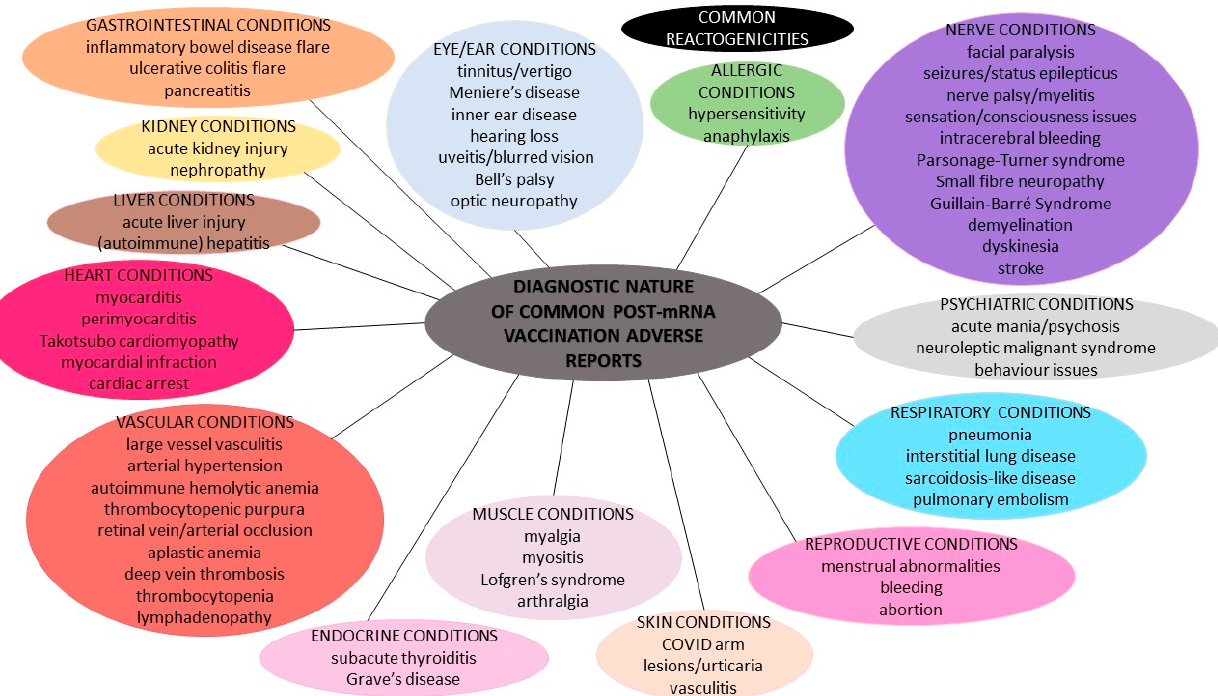
Figure 1. Diagnostic nature of the spontaneous adverse events following the mRNA vaccination against COVID-19.